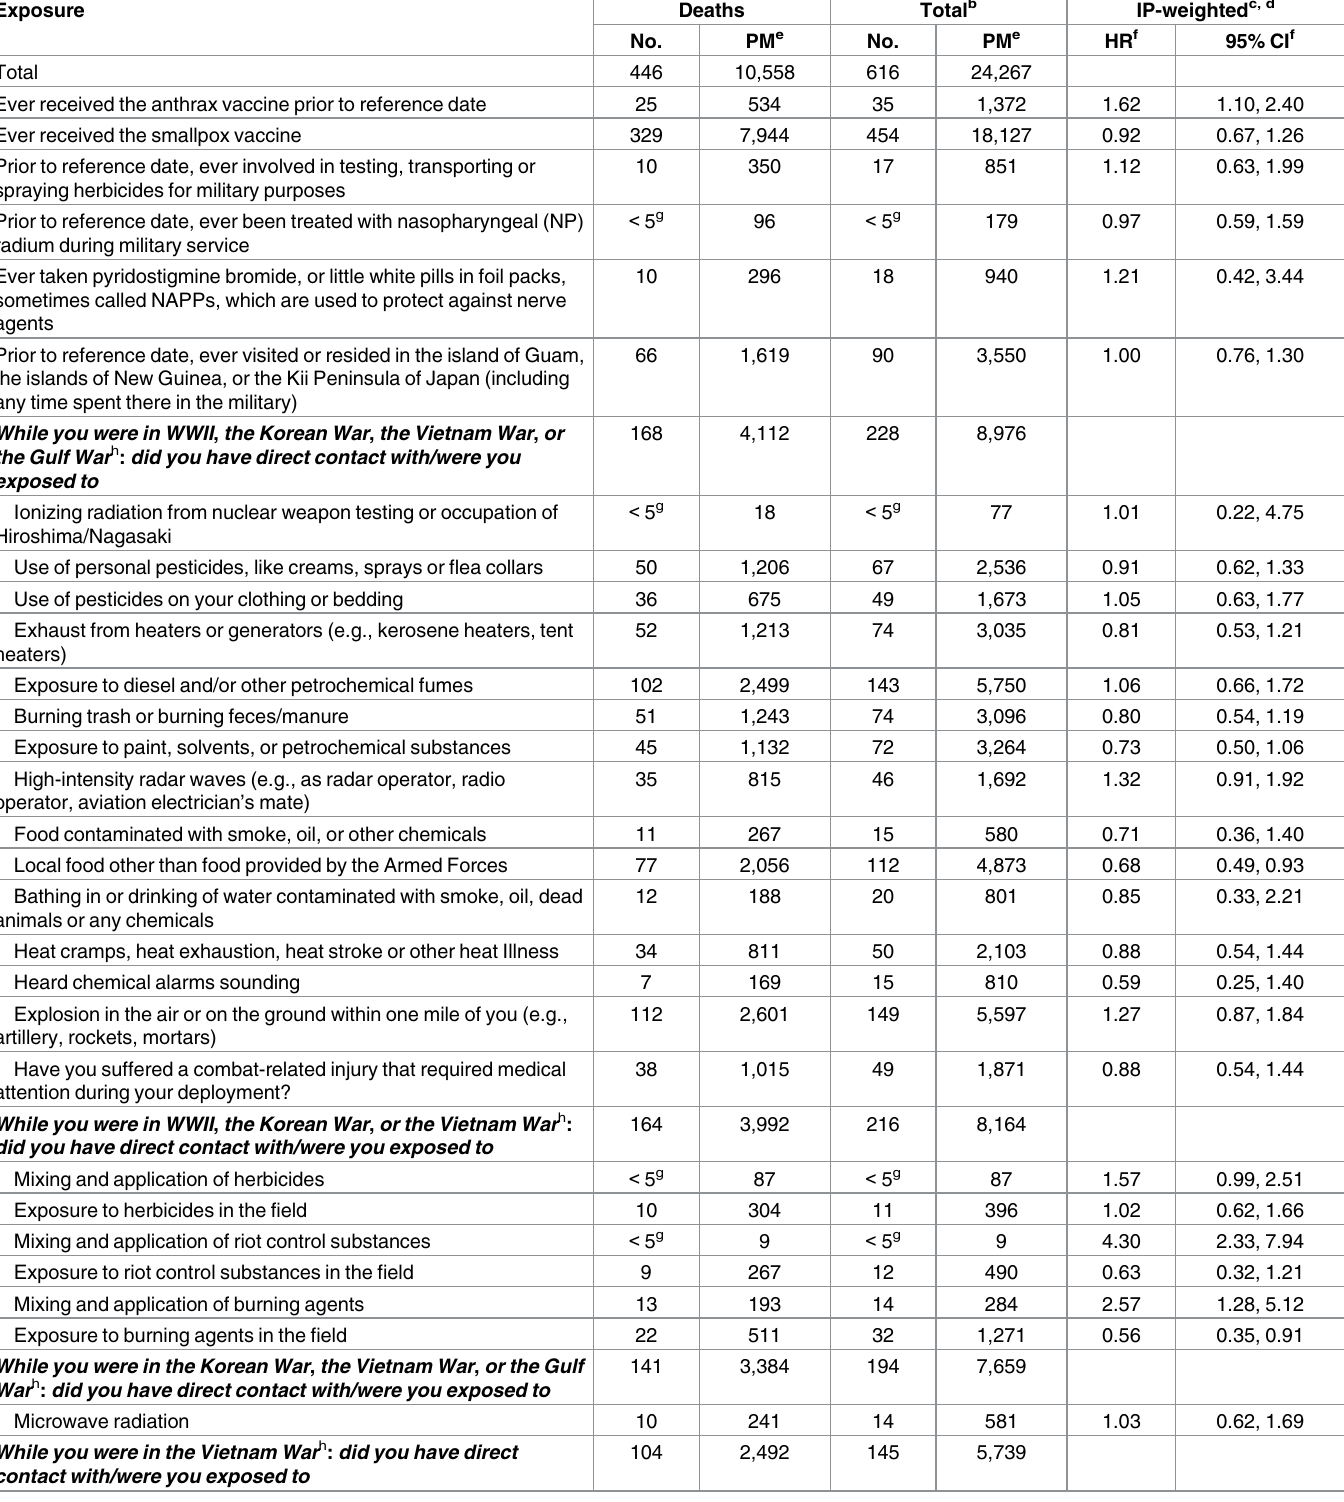
Table 5. Military exposures and amyotrophic lateral sclerosis survival in GENEVA a , United States of America, 2005–2013. Exposure Deaths Total b IP-weighted c, d